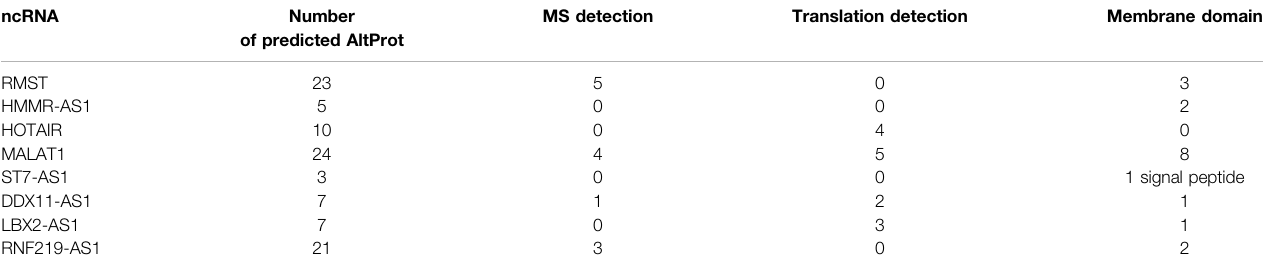
TABLE 1 | Prediction of AltProt from ncRNA described in the literature involved in the pathology of GBM. The predicted AltProts are characterized by the detection of their peptides in the mass spectrometry data (MS detection) and their detection in the Ribo-seq data (translation detection), as well as the description of the known domains with the focus on the regions described to be the transmembrane (membrane domain).